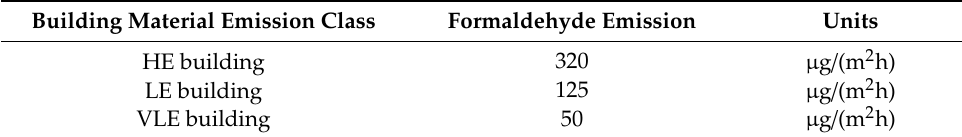
Table 1. Formaldehyde emission rates for di ff erent emission classes. HE: high-emitting, LE: low-emitting, VLE: very